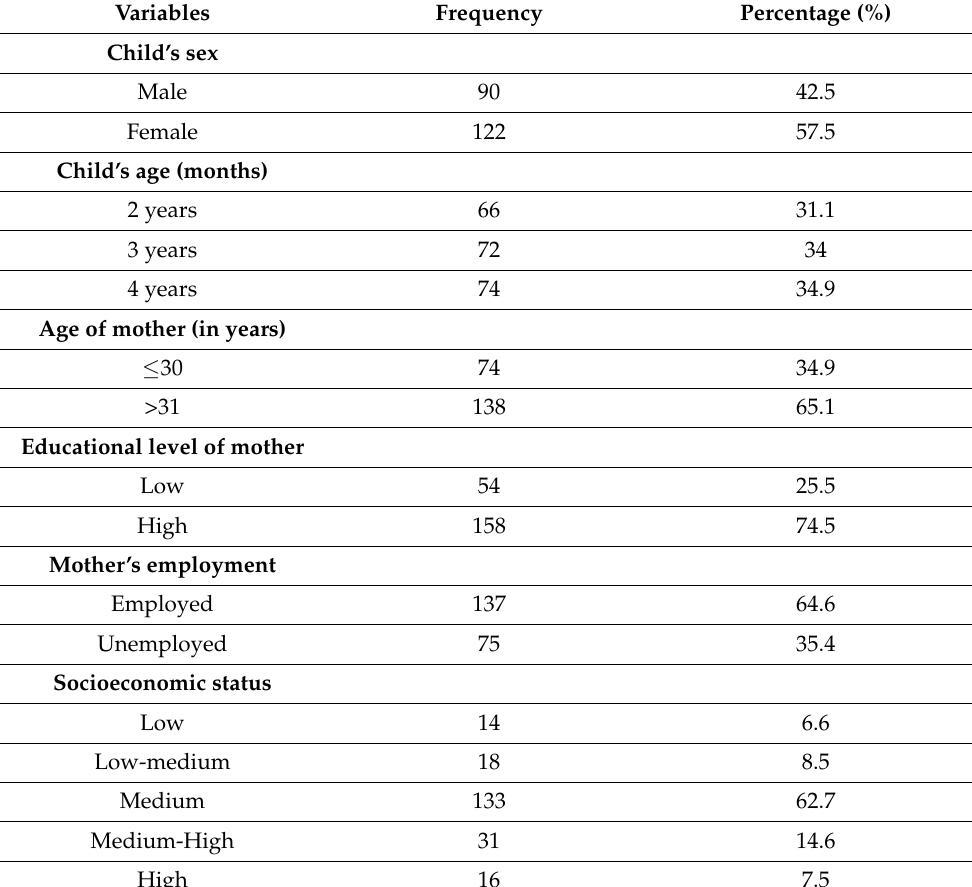
Table 1. Sociodemographic characteristics of the sample ( n =